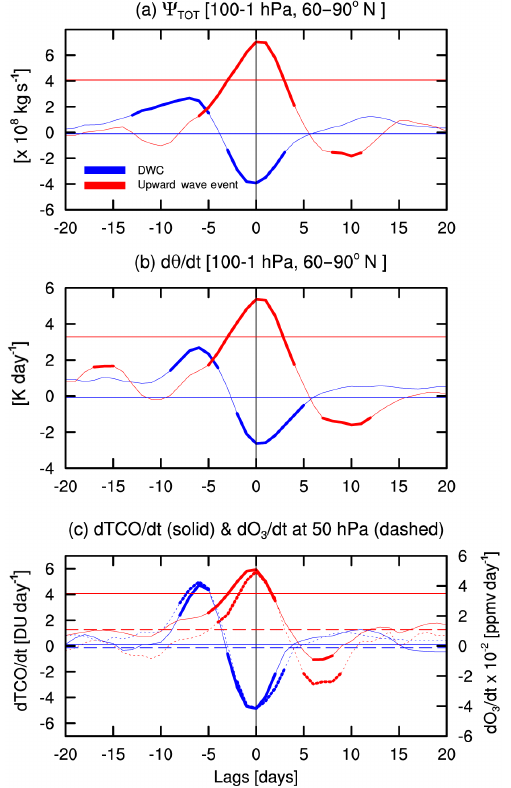
Figure 4. The time evolution of residual mass–stream function anomaly, temperature, and ozone tendencies for the composite of the DWC event (blue lines) and upward wave event (red lines). (a) Residual mass–stream function anomaly and (b) temperature tendency averaged from 100 to 1hPa and 60 to 90 ◦ N. (c) Total col- umn ozone tendency (solid lines) and mixing ratio ozone tendency (dashed lines) at 50hPa, averaged between 60–90 ◦ N. The horizon- tal lines indicate the time-integrated significant values of each quan- tity over the life cycle. The time-integrated values for the upward wave event are divided by 10 for display purposes. Statistical sig- nificance at the 95% level is denoted with thick solid lines based on a 1000-trial Monte Carlo